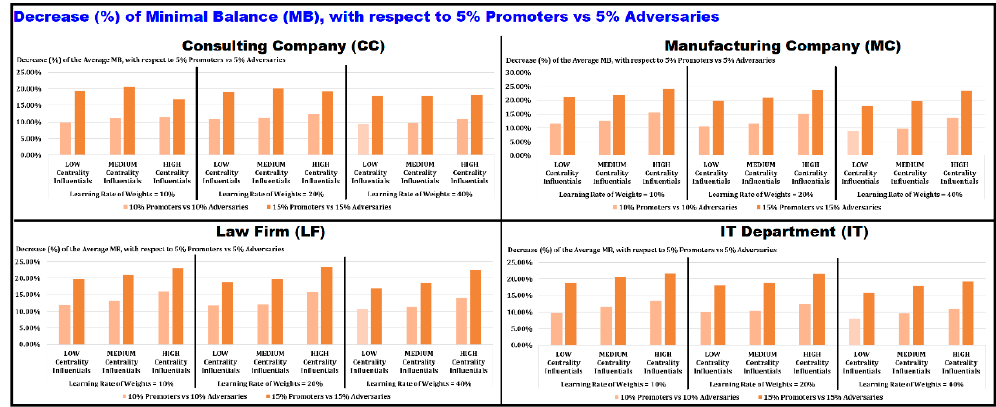
Figure 7. Relative Increase (%) of Final Negative Links (blue horizontal lines in Figure 4) for the selected values of learning rate and number of promoters and adversaries (Table 3). The increase of Final Negative Links when the position of promoters and adversaries changes from low centrality to medium centrality is indicated in the left triad of columns. The right triad of columns show the increase when the position of promoters and adversaries changes from low centrality to high centrality.